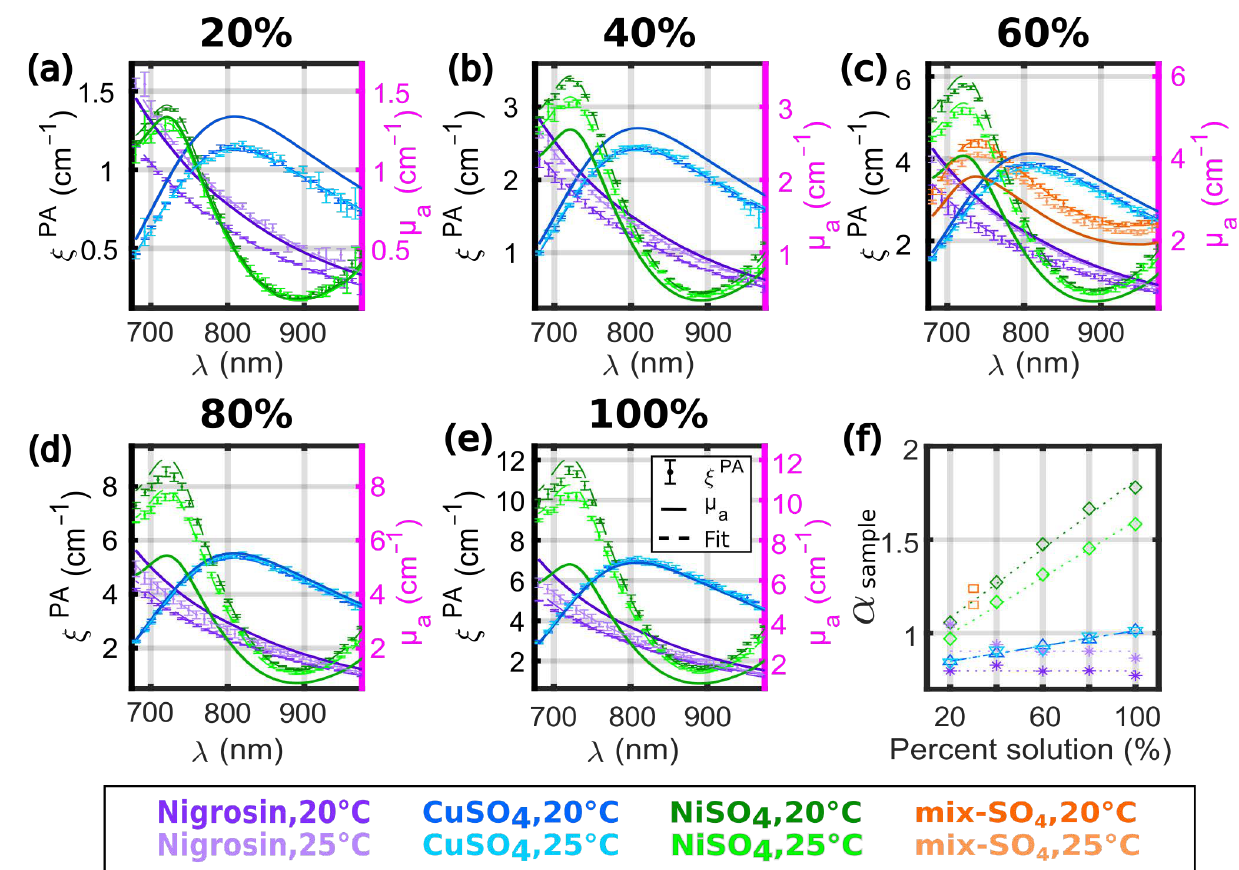
Figure 7. Influence of the concentration and the temperature on the spectra ξ PA ( λ ) for the nigrosin and the sulfate solutions. ( a – e ) Spectra for the different percent solutions and two different temperatures (20 ◦ C and 25 ◦ C). The absorption coefficient µ a ( λ ) is displayed with a solid line. The spectra ξ PA ( λ ) were measured twice in four tubes (total of 8 evaluations) for each temperature, and the median ± MAD values were displayed with dot markers and error bars. Two different tones of the same color were used for the different temperatures, and the lighter tone was used for 25 ◦ C. The fits of µ a ( λ ) to (cid:101) ξ PA ( λ ) (with an assumption of direct proportionality) are shown with a dashed line of the same color as for ξ PA ( λ ). The percent solutions are separated in 5 graphs for the sake of legibility: ( a ) 20%, ( b ) 40%, ( c ) 60%, ( d ) 80%, and ( e ) 100%. The mix-SO 4 is displayed in ( c ). ( f ) The proportionality factor between (cid:101) ξ PA ( λ ) and µ a ( λ ) as a function of the percent of the stock solution. The mix-SO 4 is displayed at 30% because it is comprised of 30% of the stock solution of NiSO 4 . The dotted lines are the linear regressions. The same colors as for ξ PA ( λ ) were